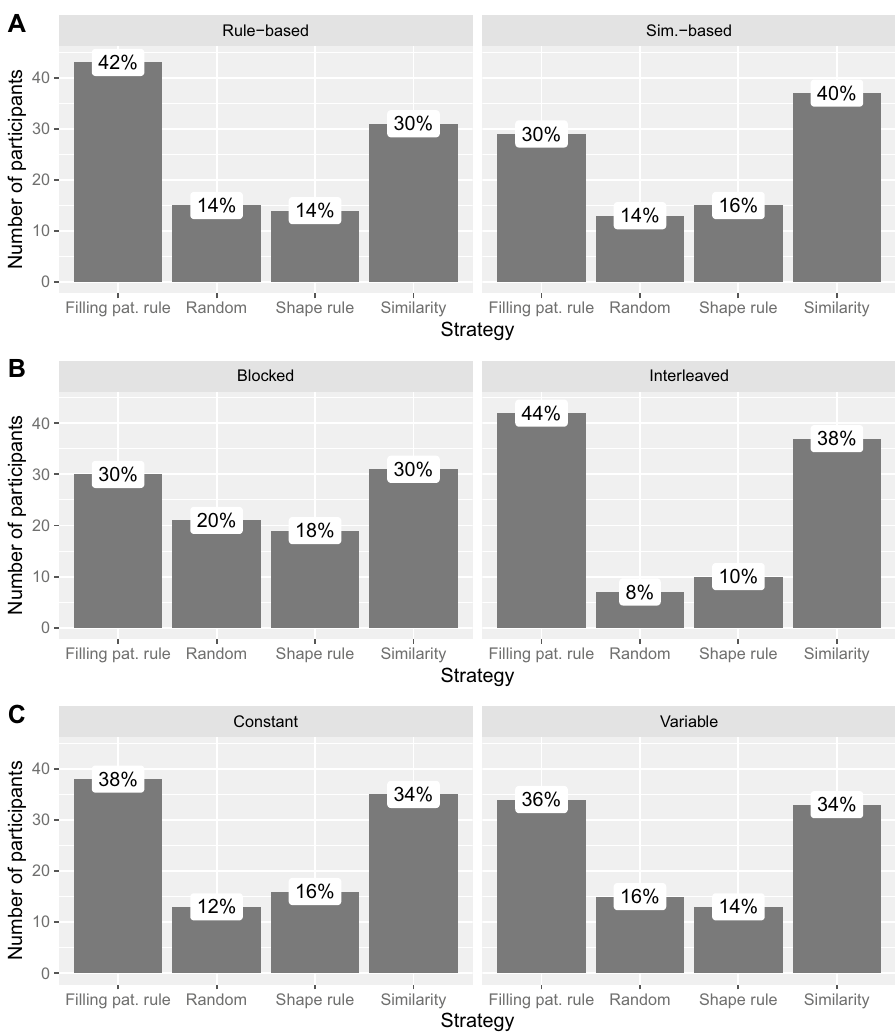
Figure 10. Partition of the participants in each main order type based on which strategy they most resemble. Graph ( A ) shows the within-category orders, graph ( B ) the between-category orders, and graph ( C ) the across- blocks manipulations. When there were multiple closest strategies, all of them were taken into account. The closest strategy was computed using the L 1